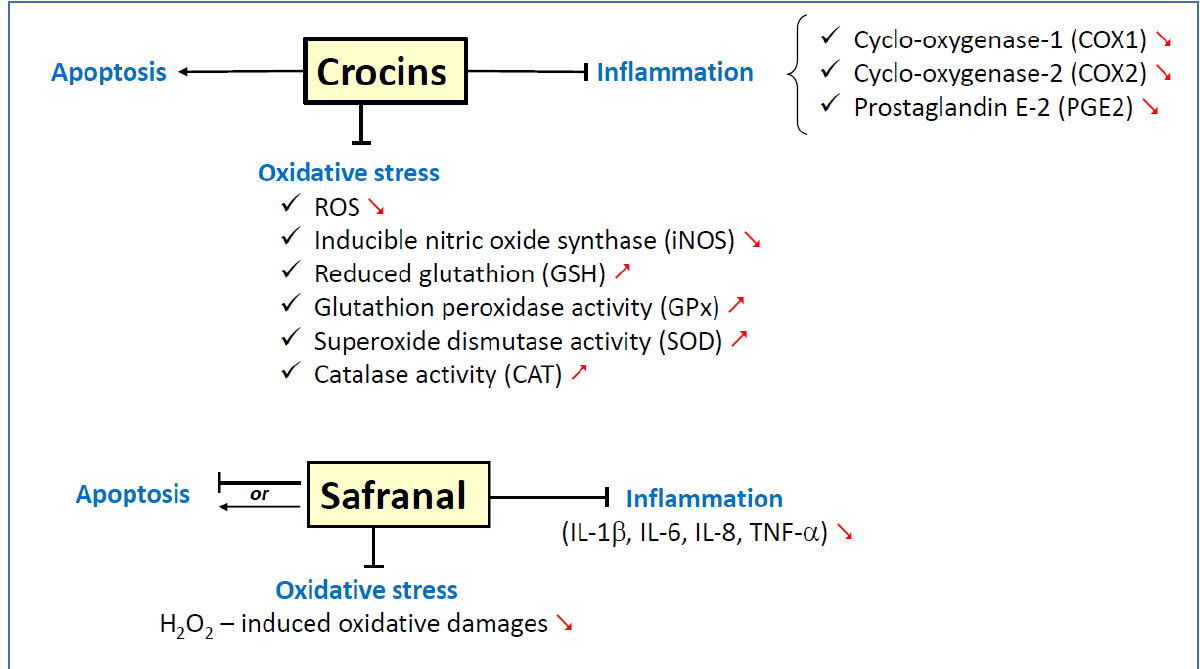
Figure 3. Beneficial effects of crocin and safranal molecules on inflammation, oxidative stress and apoptosis. In different cellular and animal models, crocin molecules counteract inflammation by reducing the production of COX1 and 2 as well as PGE2, oppose oxidative stress by decreasing the production of ROS and iNOS and by stimulating antioxidant defenses (increase in GSH, GPx, SOD and CAT levels). As for safranal, it reduces the production of pro-inflammatory cytokines and reduces oxidative stress stimulated by H 2 O 2 . Moreover, crocins induce apoptosis, while safranal activates or inhibits cell death, depending on the models used. The signaling pathways on which these molecules act are still not well known but the PI3K/Akt and MAPK/ERK pathways could be involved. ↗ means increase, ↘ means decrease